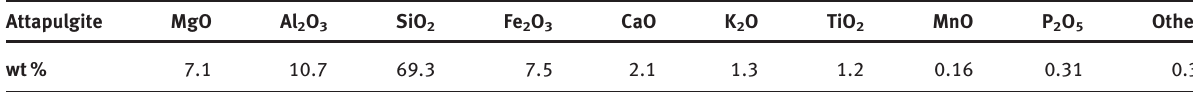
Table 1: Elemental analysis of minerals using the X-ray fluorescence technique. Attapulgite